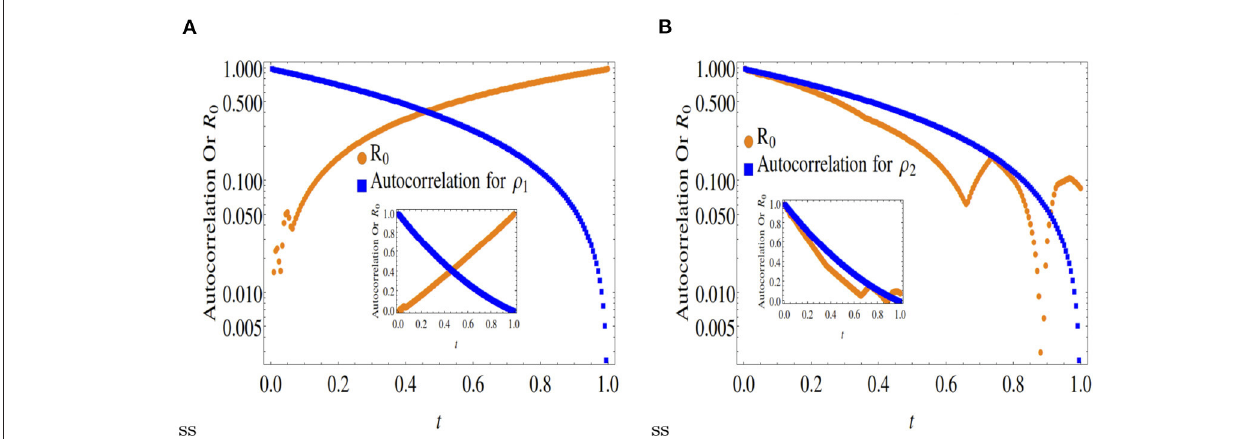
FIGURE 1 | Comparison of normalized autocorrelation and R 0 at x = 0.2. Outset is in log scale and inset is in original scale. (A) Shows that the autocorrelation (in blue) is decreasing at later times although the R 0 is increasing for the species ρ 1 (orange curve). This indicates that at x = 0.2 the production of ρ 1 occurs from its own population at small timescales. On the other hand in (B) , the simultaneous decreasing behavior of the autocorrelation and R 0 indicate that at x = 0.2 the production of ρ 2 also occurs at smaller timescales. However, in case of ρ 2 , its production occurs due to the conversion of ρ 1 into ρ 2 , since the measure of self-creation R 0 is decreasing in this case.